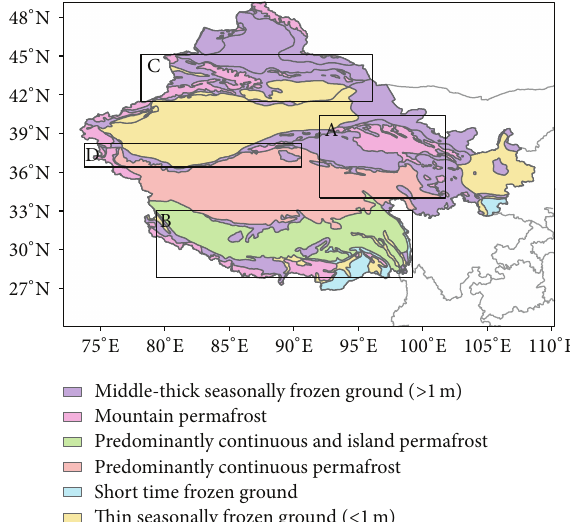
Figure 9: Distribution of frozen soil types over northwestern